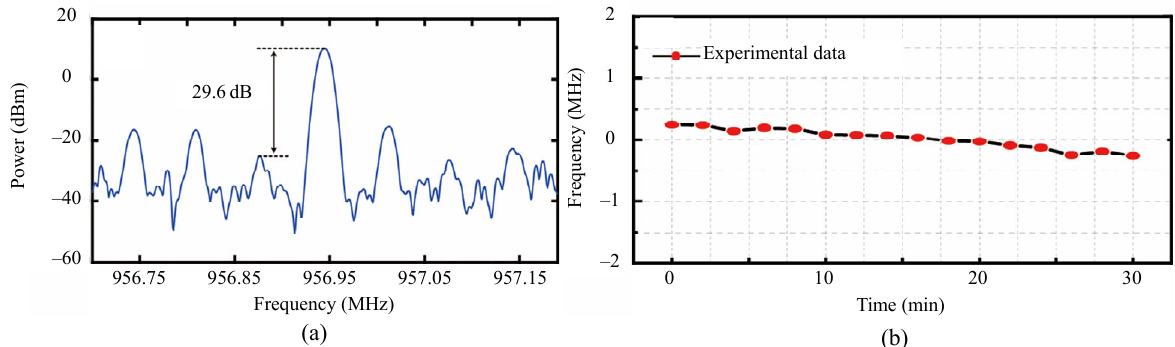
Fig. 4 Side-mode suppression ration and stability test of the designed dual-loop OEO: (a) electrical spectrum of the generated 956.95 MHz signal and (b) stability of the OEO at temporal duration of 30